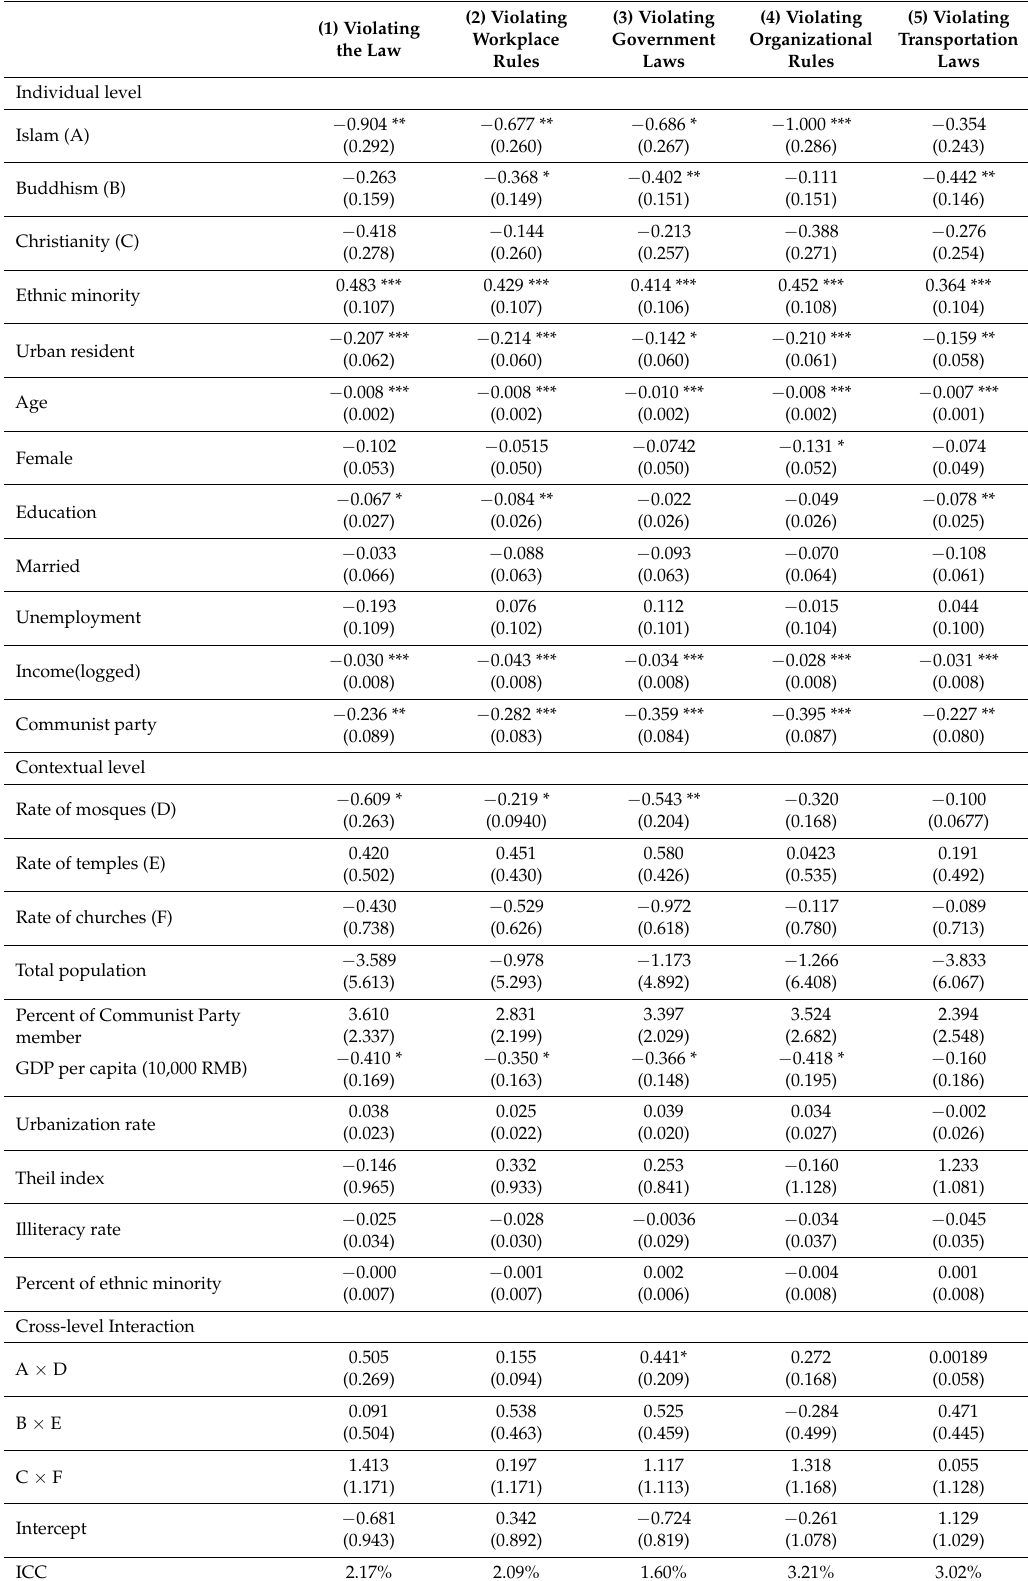
Table 3. Religion as an individual and contextual control, with cross-level interaction (individual N = 8224; province N =